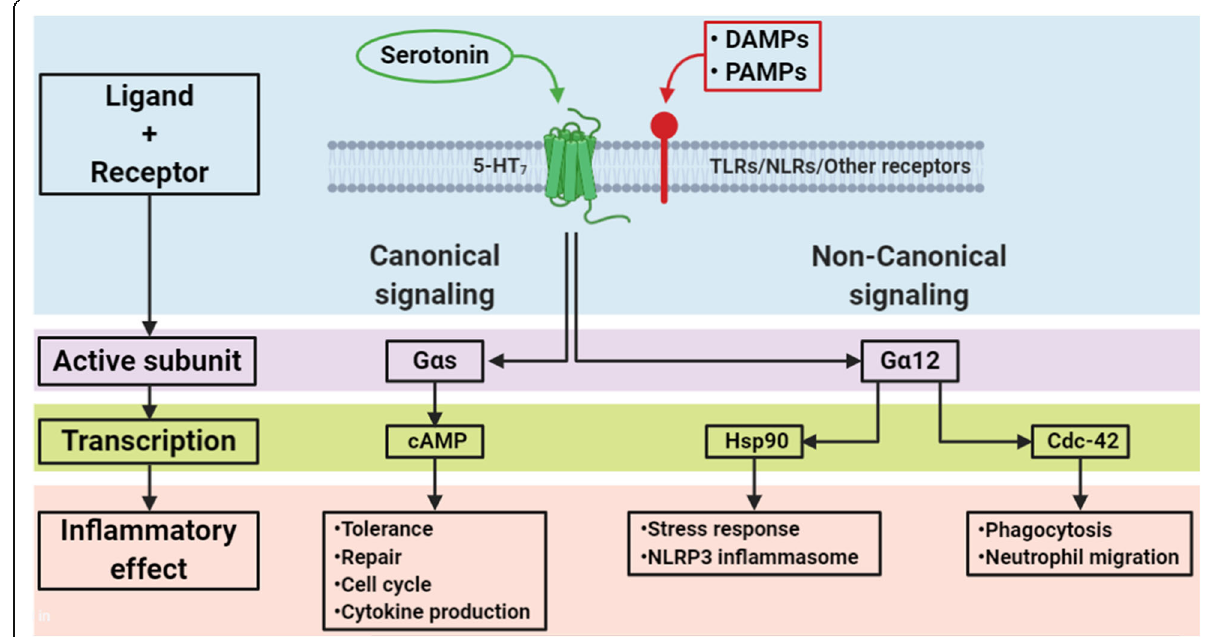
Fig. 1 Signaling pathways downstream of 5-HT 7